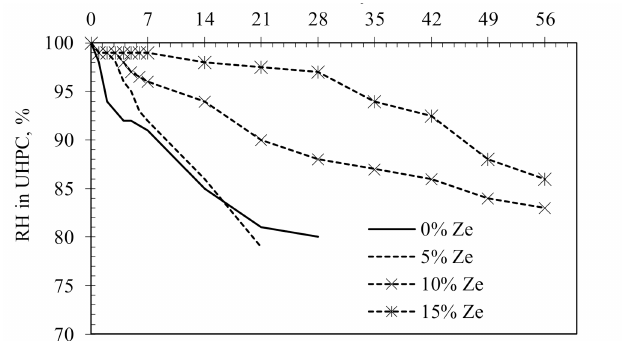
Figure 6. The internal relative humidity (RH) evolution over curing time in